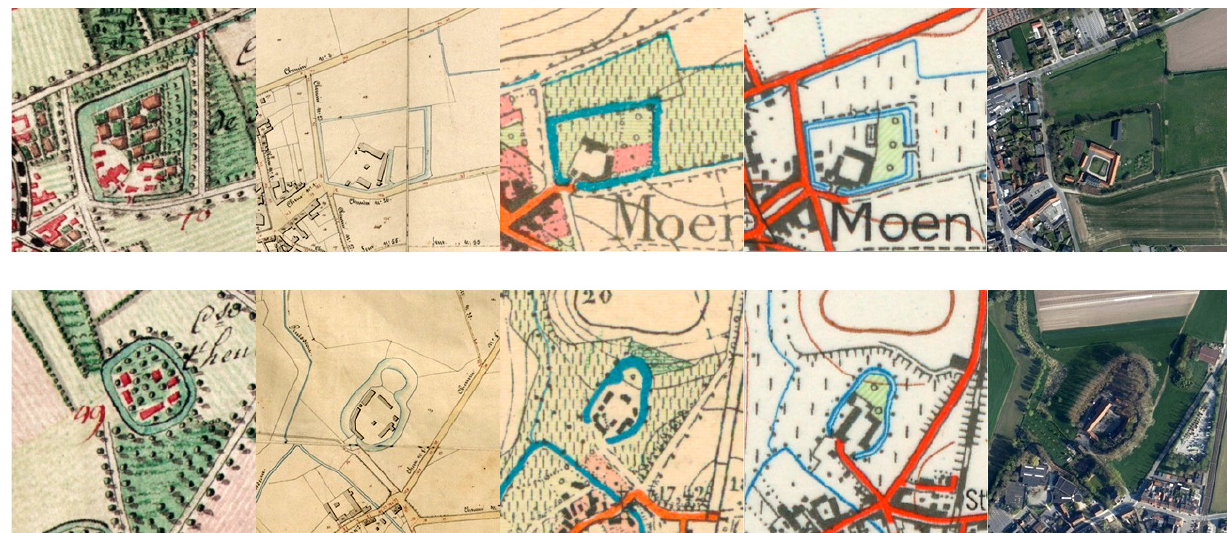
Figure 4. Farmstead Goed te Mouden in Moen (top) and farmstead Heerlijkheid van Heule (bottom) evolution. Sources from left to right: de Ferraris’ 1771 map (Geopunt Vlaanderen, n.d.‐a), 1843 Atlas der Buurtwegen (Geopunt Vlaanderen, n.d.‐b), 1904 topographic map (Zwartjes, 2020a), 1969 topographic map (Zwartjes, 2020b), and Google